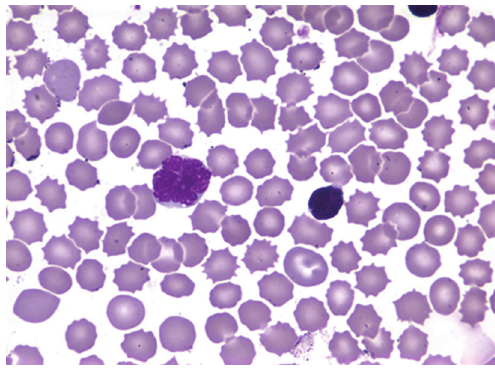
Figure 2: A Flower cell in the peripheral smear characteristic of